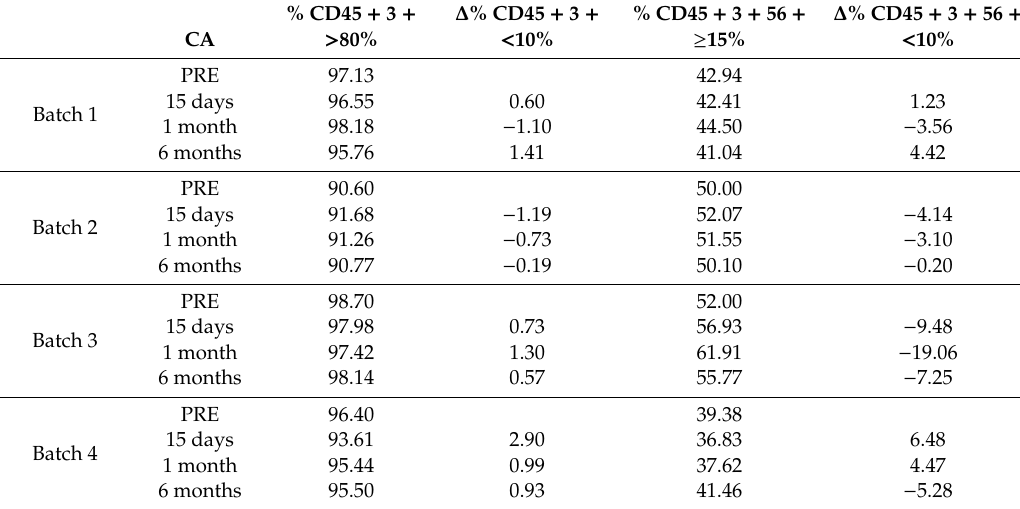
Table 2. Identity evaluated by immunophenotype analysis on Batches 1, 2, 3 and 4. The values and relative ∆ , in percentages, were evaluated between the immunophenotype of the post-thawing conditions at di ff erent time periods: 15 days, 1 month and 6 months, and in two cases, also at 9 and 12 months vs. pre-freezing conditions (PRE). CA = Acceptance, criteria, the limits of which are indicated in bold, are reported. ND = condition not